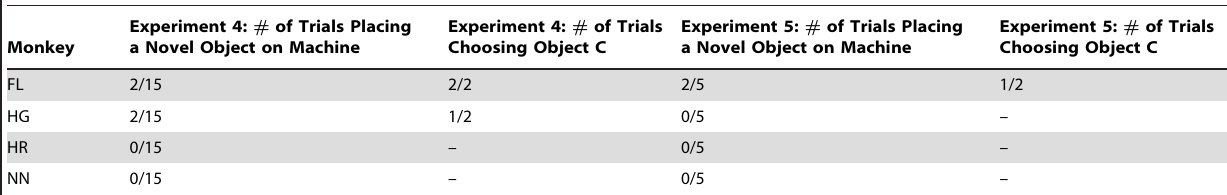
Table 3. Results of Experiments 4 and 5 across all participants.